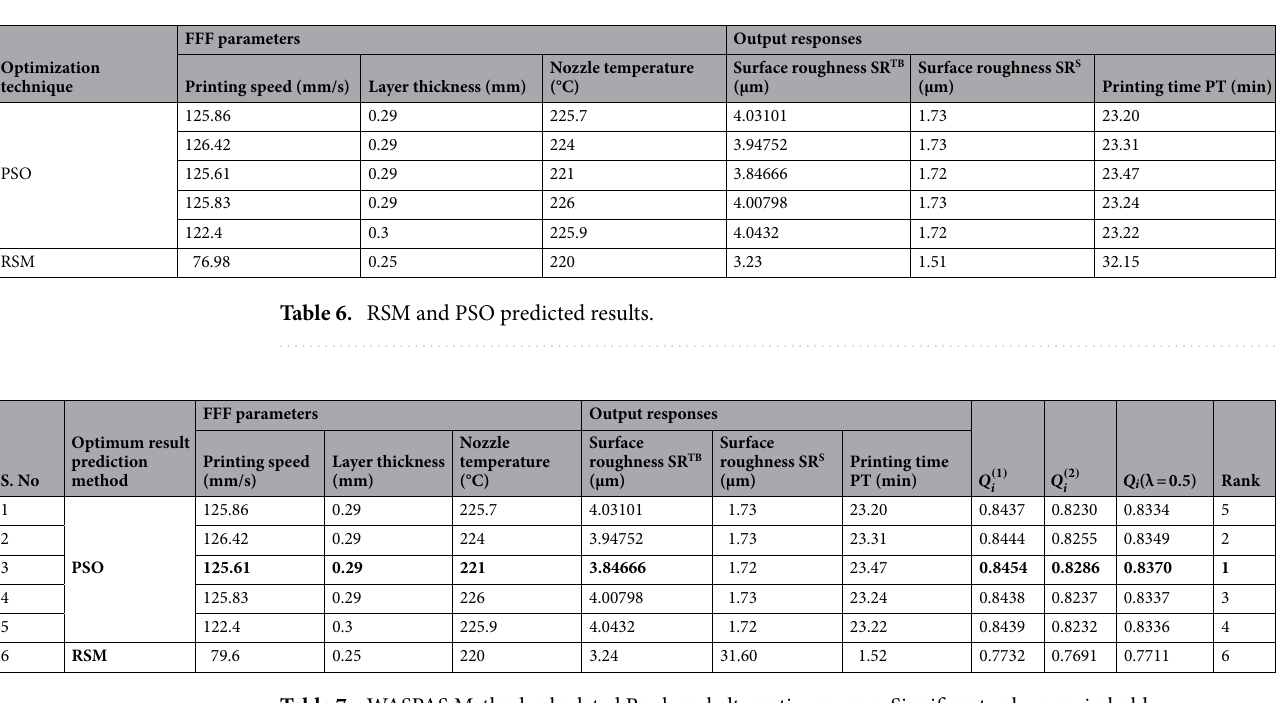
Table 7. WASPAS Method calculated Rank and alternatives scores. Significant values are in